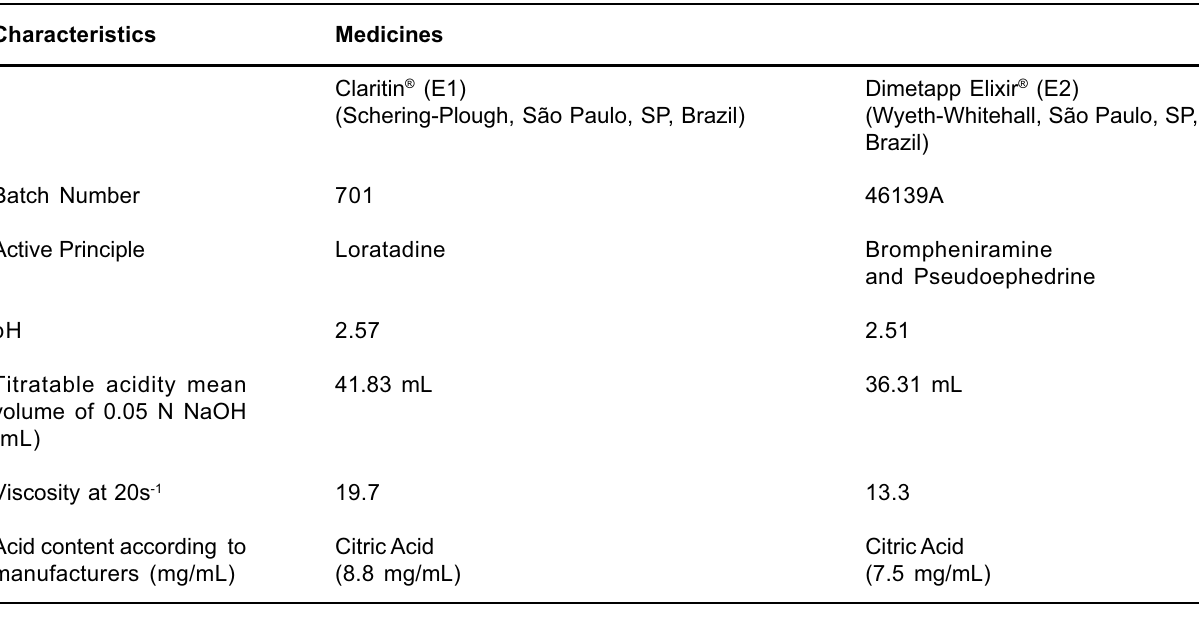
TABLE 2- Characteristics of the acidic medicines used in the present study